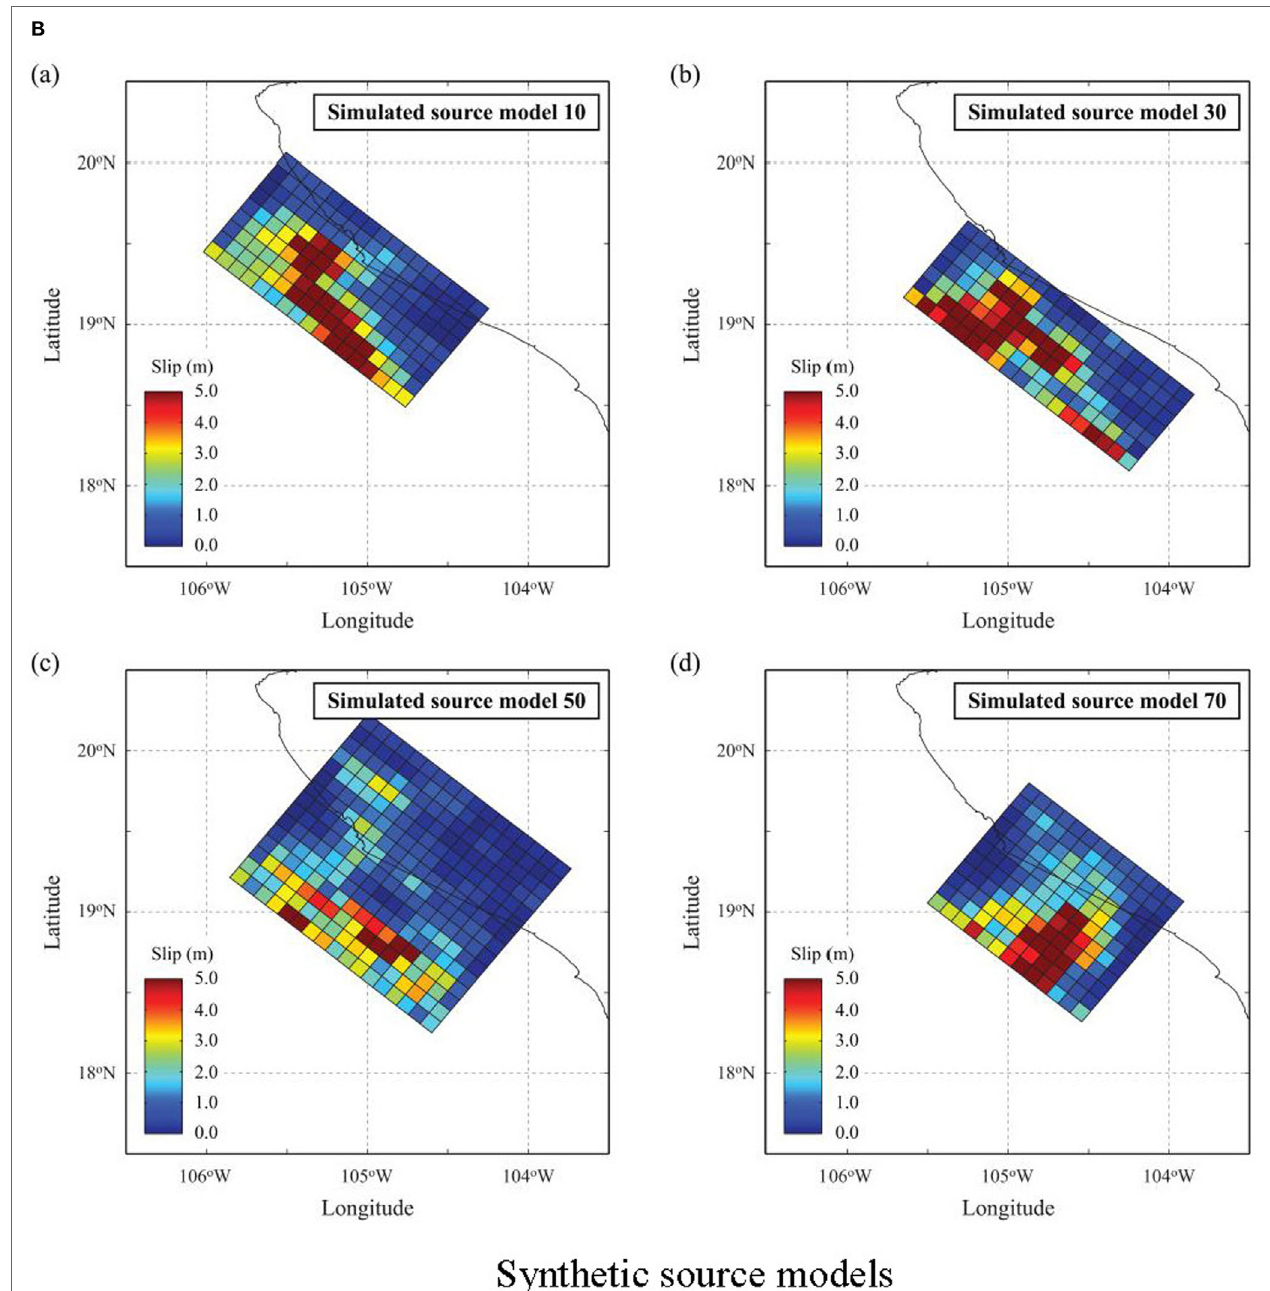
FigUre 6 | Stochastic source models for the 1995 Colima Earthquake scenario by considering prediction errors of the scaling relationships. (a) Mendoza–Hartzell model for the 1995 Colima Earthquake. (B) Synthetic source